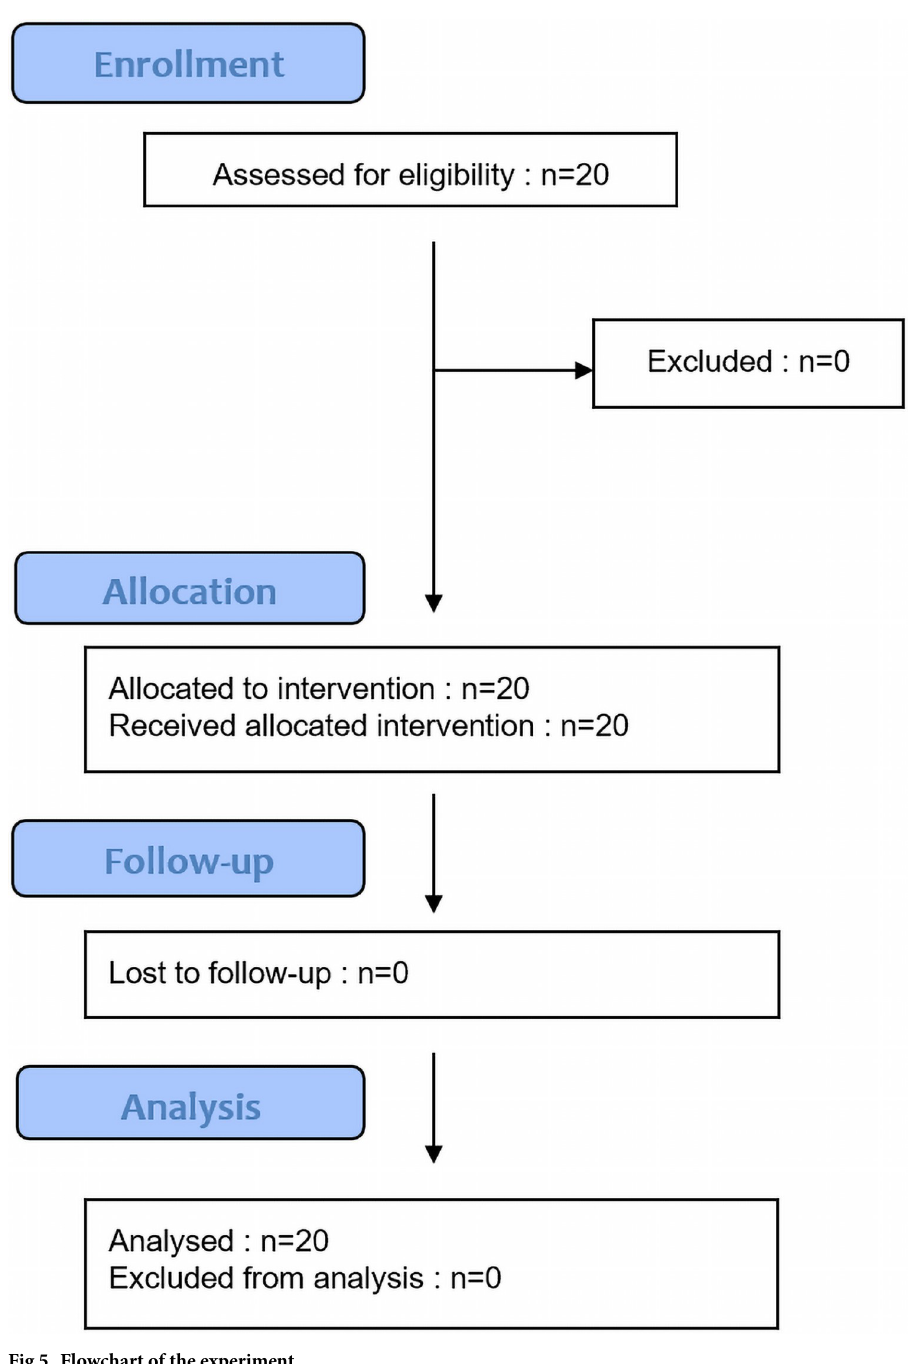
Fig 5. Flowchart of the